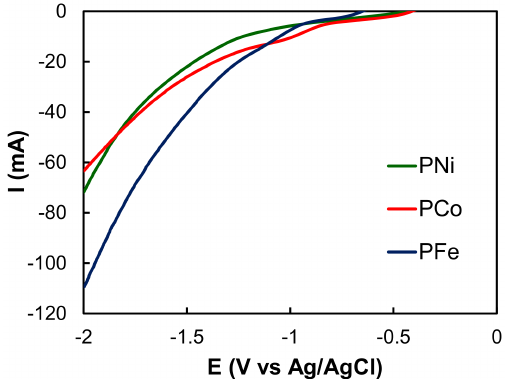
Figure 8. Linear sweep voltammetries obtained from the equilibrium electrode potential to a negative electric potential of − 2.00 V vs. Ag/AgCl. Scan rate: 5 mV/s. Fresh electrodes in CO 2 saturated 0.1 M KHCO 3